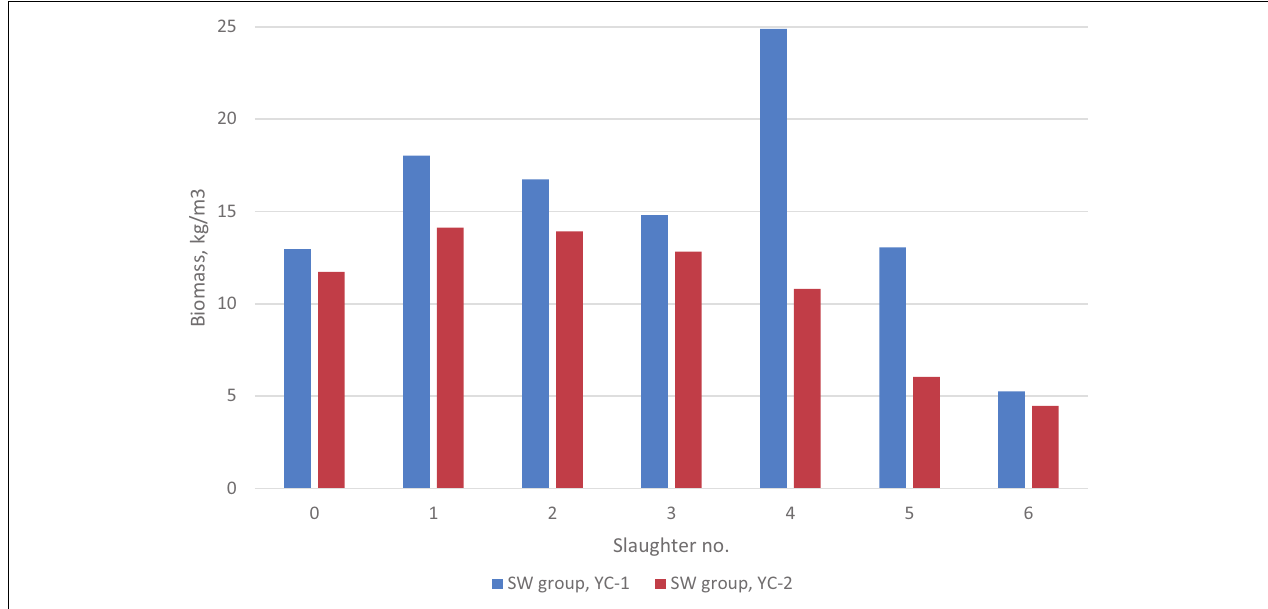
FIGURE 1 | Biomass for the SW group at the start (0) and at each of the six slaughter events of the 2 year-classes. For the SA group, the biomass at slaughter was 18 kg/m 3 (yc 1) and 27 kg/m 3 (yc 2).